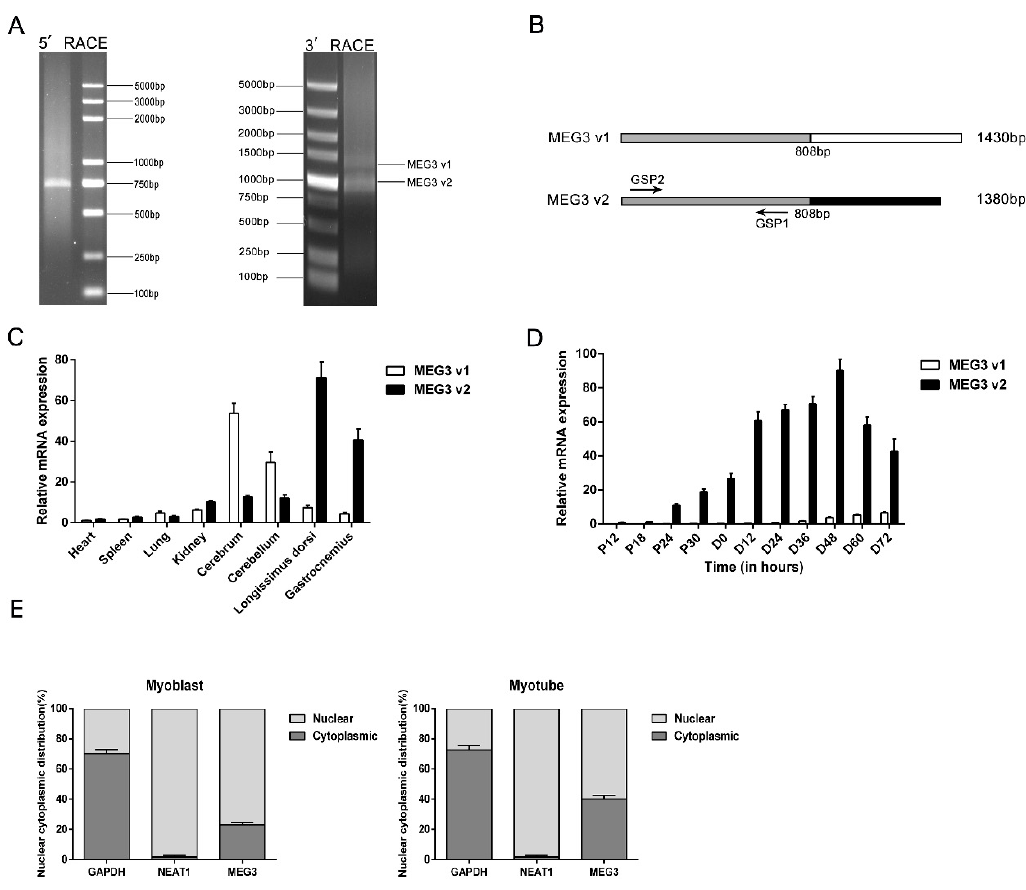
Figure 1. Characterization of the lncRNA MEG3 gene. ( A ) Results of 5 ′ rapid amplification of cDNA ends (RACE) and 3 ′ RACE of lncRNA MEG3 in porcine skeletal muscle. The arrows represent the two transcripts variants of MEG3 . ( B ) Structure of two transcript variants ( MEG3 v1 and MEG3 v2) of the porcine MEG3 gene. The grey shades mean that the two transcripts share the same front parts. GSP1 and GSP2 are the gene-specific primers for 5 ′ and 3 ′ RACE of MEG3 . ( C ) Expression levels of the two MEG3 variants in heart, spleen, lung, kidney, cerebrum, cerebellum, longissimus dorsi and gastrocnemius. ( D ) Expression levels of the two MEG3 variants during porcine myoblast proliferation and differentiation. ( E ) The distribution of MEG3 core variant transcript ( MEG3 v2) in the cytoplasm and nuclei of porcine proliferous myoblast and myotube differentiated for 48 h. NEAT1 is a known nuclear lncRNA, and GAPDH is a cytoplasmic-enriched gene. The relative RNA levels were normalized to those of the control 18S rRNA . Error bars represent mean ± SEM of three biological replicates. Statistical significance of differences was assessed by Student’s t -test. NC, negative control.